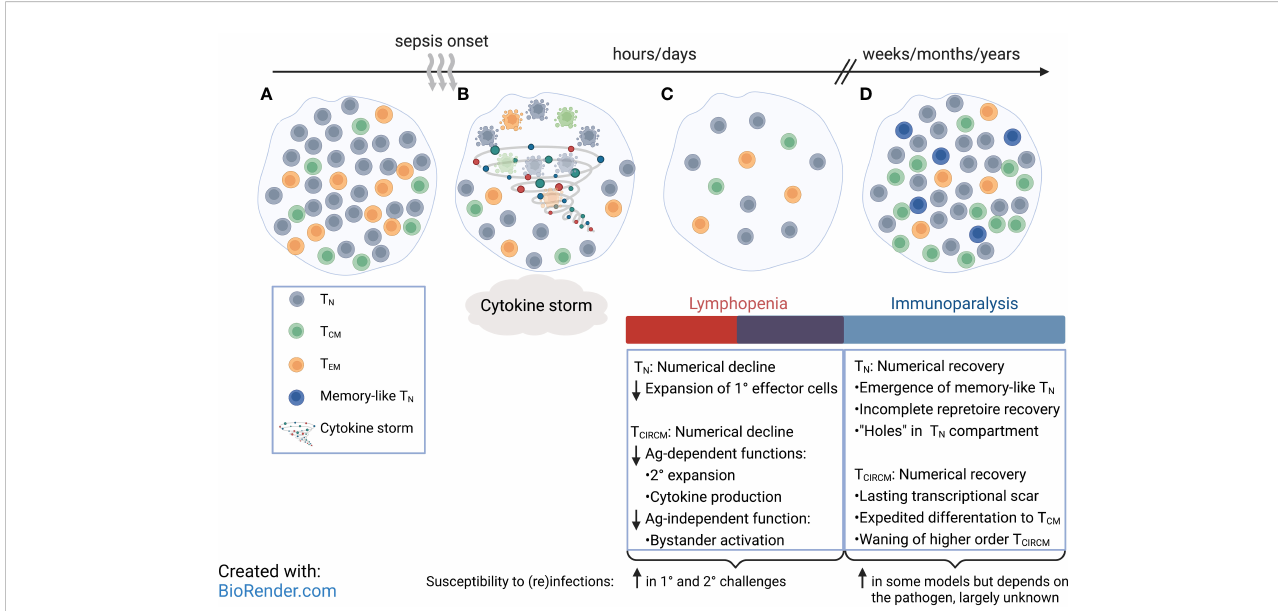
FIGURE 1 Compositional and phenotypical changes of circulatory CD8 T cell pool after sepsis. (A) Circulatory CD8 T cell pool consists of naïve CD8 T (T N ) cells and memory CD8 T (T CIRCM ) cell subsets. (B) Increased levels of circulating pro- and anti-in fl ammatory cytokines mark the initial phase of a septic insult, followed by induction of apoptosis in CD8 T N and T CIRCM in a stochastic manner. (C) Rapid loss of CD8 T N and T CIRCM and other lymphocytes result in transient lymphopenia, accompanied with early signs of immunoparalysis. (D) Number of CD8 T N and T CIRCM return to pre-sepsis values; however, some CD8 T N express memory-like phenotype, and the central memory CD8 T (T CM ) cells are enriched over effector memory CD8 T (T EM ) cells. Many patients continue to suffer from a long-lasting state of